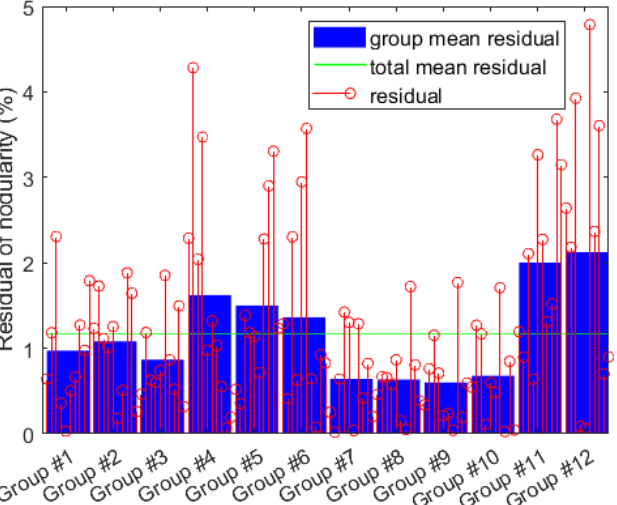
Figure 9. (Color Online) The residual between the regression function and destructive data of hierarchical Bayesian regression model from the first week only.